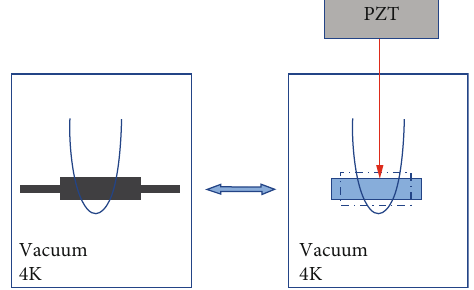
Figure 5: The suspension of the broadband detector